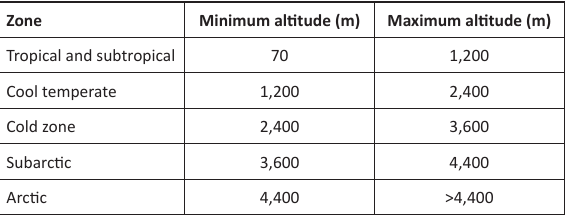
Table 1. Climatic Zones of Nepal. Adapted from (Savada 1991; RAOnline 2010a; Vetaas & Grytnes